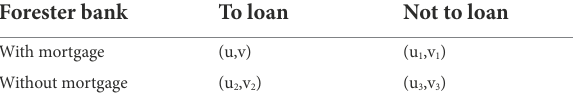
TABLE 1 Result of game played by the three parties. Forester